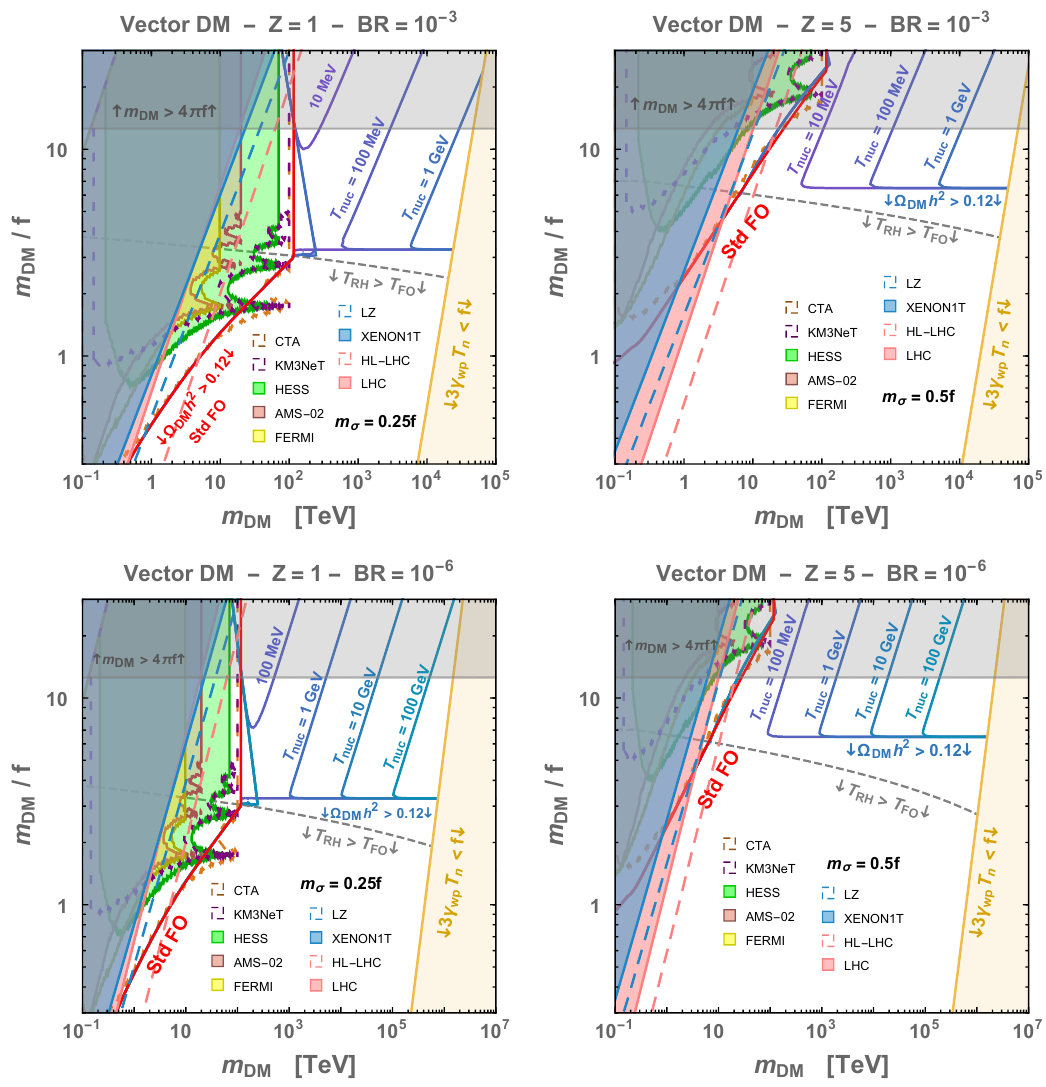
Figure 15 . Supercooled dilaton-mediated vector DM. Lines and shadings as in figure